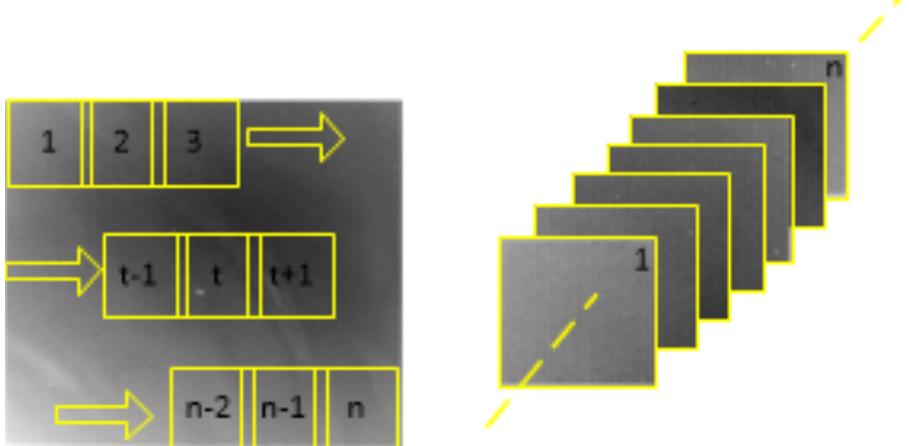
Figure 2. Infrared tensor image construction